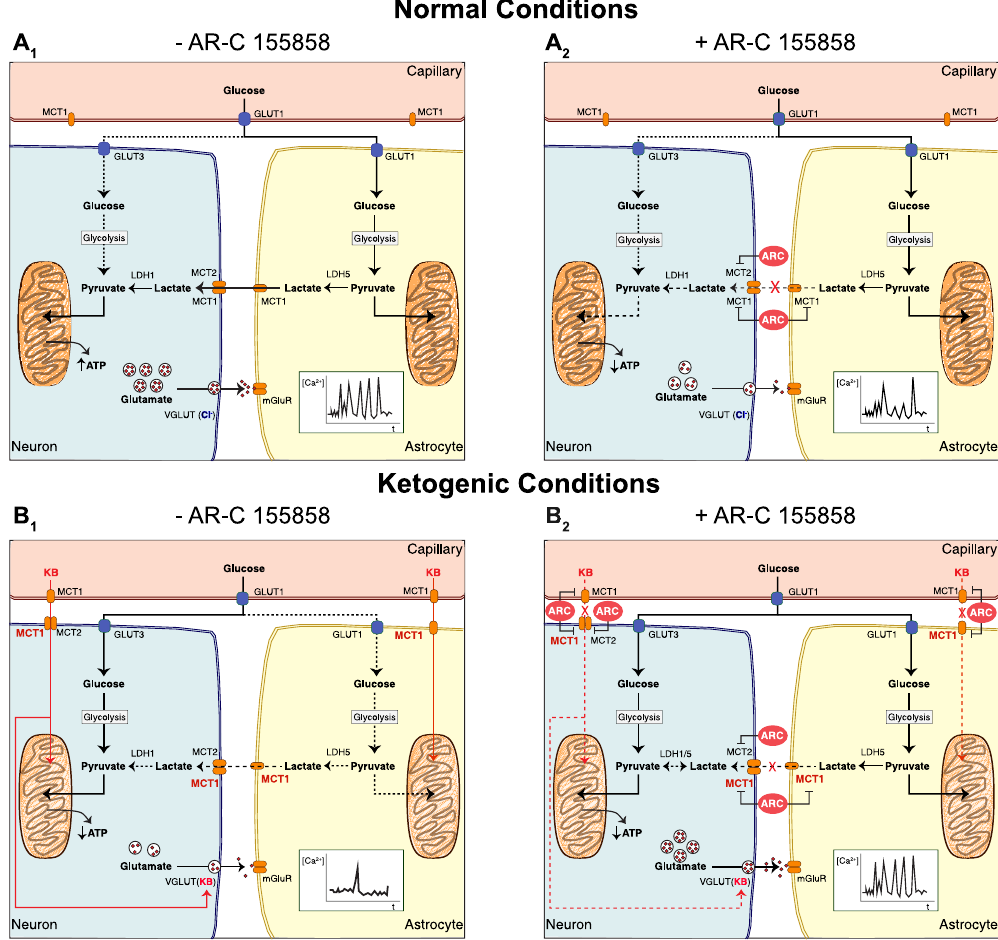
Figure 8. Schematic model of the mechanism of action for MCTs during epileptiform activity in CD and KD. During normal conditions, astrocytes take up glucose to produce lactate, and then export it to the neurons via MCT. During epileptiform activity, neurons increase their energetic demand, which leads to an increase in the ATP production and glutamate release ( A 1 ). When MCT1 and MCT2 transport activity are inhibited by AR-C155858 (ARC), the ANLS is disrupted, leading to a decrease in the ATP production, and consequently to a decrease in epileptiform activity ( A 2 ). Under ketogenic conditions, KB concentration increases, leading to a reduction in the glycolytic rate in the astrocytes, which in turn reduces lactate and ATP production, in astrocytes and neurons, respectively. Neurons also take up KB, and now the availability of glucose increases for them. KB enter to the mitochondria and activate the TCA cycle, in addition, they modulate the glutamate release from VGLUTs, which leads to a dampening in the epileptiform activity ( B 1 ). Inhibition of MCT1 and MCT2 with AR-C155858 inhibits the uptake of KB and lactate via MCT in astrocytes and neurons. Epileptiform activity increases because KB cannot longer modulate VGLUTs, and due the conversion of the remaining lactate into pyruvate in the neurons ( B 2 ). See more details in the